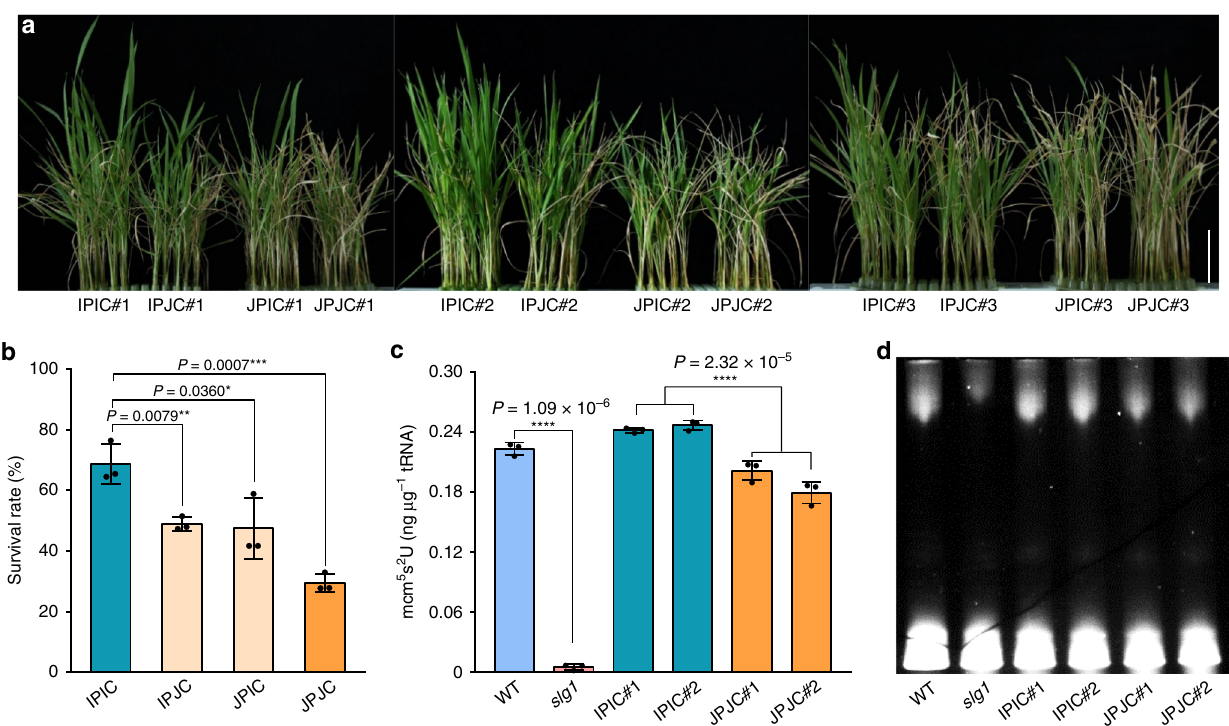
Fig. 5 SLG1 Ind -complemented plants show strong thermotolerance and high thiolated tRNA level. a , b Comparison of thermotolerance among IPIC, IPJC, JPIC, and JPJC plants. Three independent homozygous IPIC, IPJC, JPIC, and JPJC lines were selected and treated with 45 °C for 56 h and then recovered under normal condition for 10 days. Data are means ± SD ( n = 3 independent transgenic lines. Each transgenic line was analyzed with three biological replicates, with 40 – 56 seedlings per biological replicate). * P < 0.05, ** P < 0.01, *** P < 0.001, two-tailed Student ’ s t -test. Bar = 5 cm. c , d Detection of thiolated tRNAs in slg1 , WT, IPIC, and JPJC transgenic lines based on LC/MS-QQQ- ( c ) and APM- ( d ) methods. Shoots of 2-leaf-stage seedlings under normal growth conditions were sampled. The loaded amount of tRNA was 3 µ g for each lane ( d ). Data are means ± SD ( n = 3 biological replicates). **** P < 0.0001, two-tailed Student ’ s t -test. The experiment in ( d ) was repeated three times with similar results. The source data underlying ( b – d ) are provided as a Source data fi